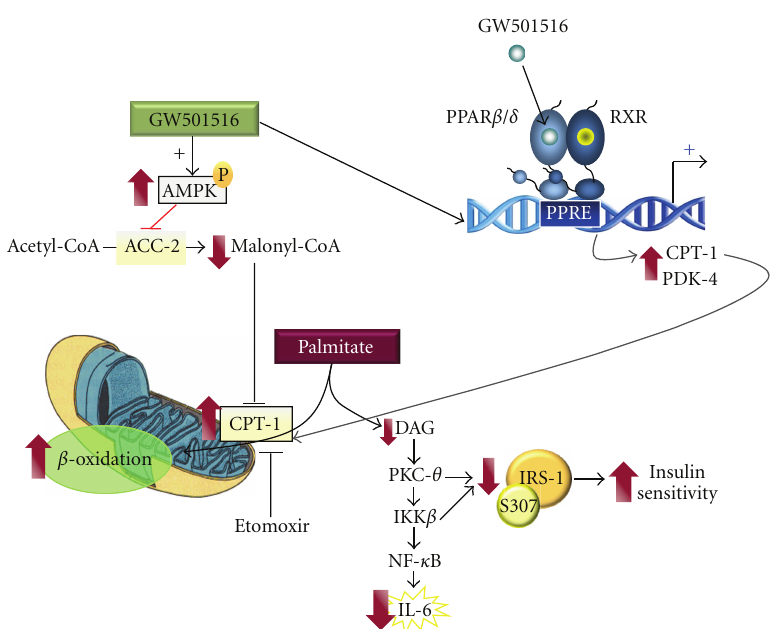
Figure 2: Potential mechanism of action involved in the reduction of insulin resistance and inflammation in skeletal muscle cells following PPAR β / δ activation by GW501516. ACC-2, acetyl-CoA carboxylase 2; AMPK, AMP-activated protein kinase; CPT-1, carnitine palmitoyltransferase-1; DAG, diacylglycerol; IKK β , I κ B kinase β ; IL-6, interleukin 6; IRS-1, Insulin Receptor Substrate 1; NF- κ B, Nuclear Factor- κ B; PDK-4, pyruvate dehydrogenase kinase 4; PKC θ , protein kinase C θ